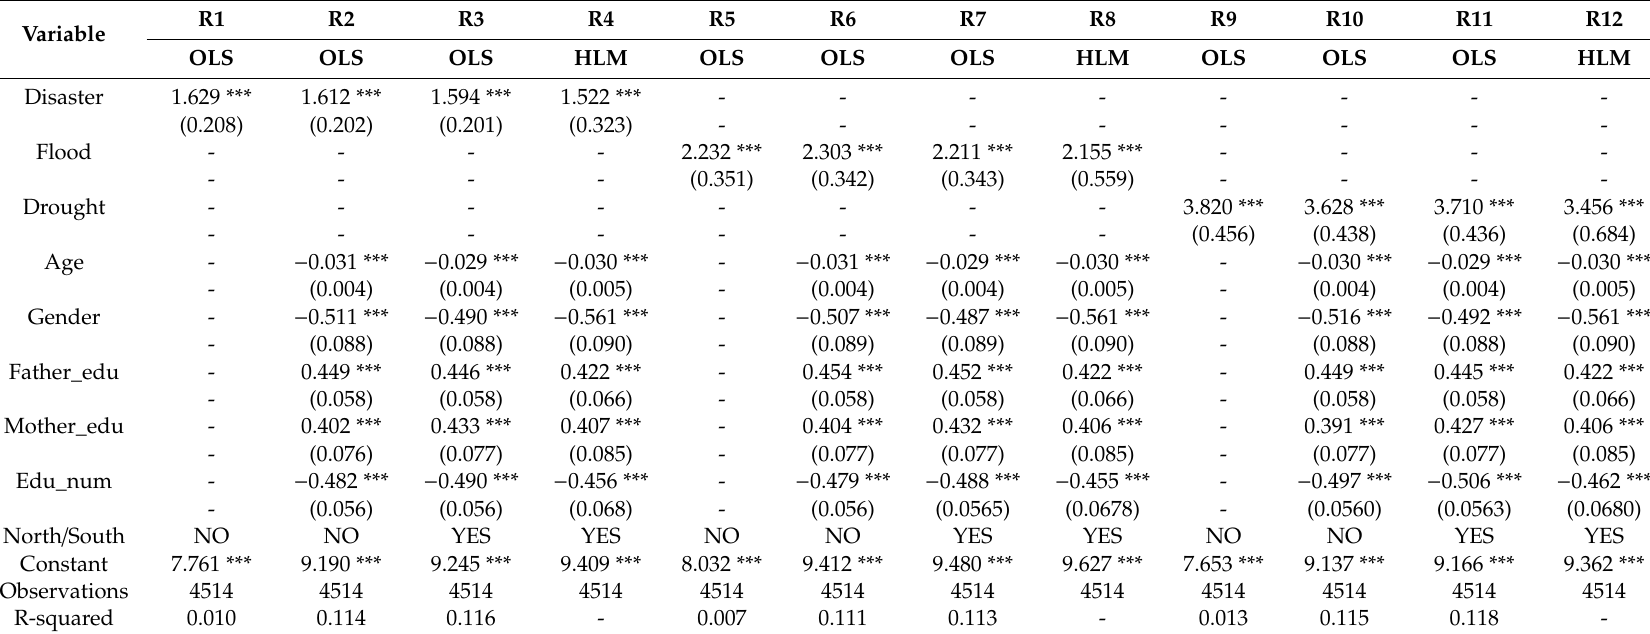
Table 7. Impact of disaster frequency on contemporary human education level, OLS